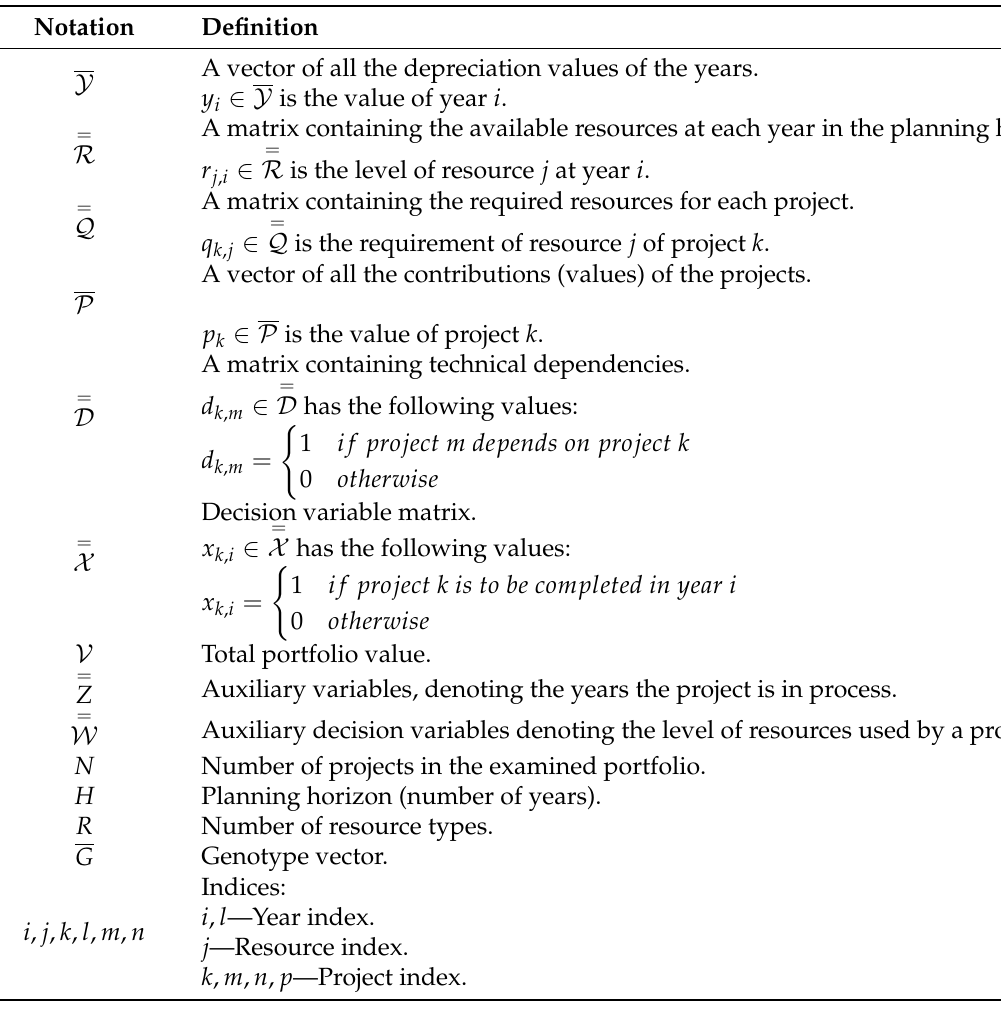
Table 2. Problem